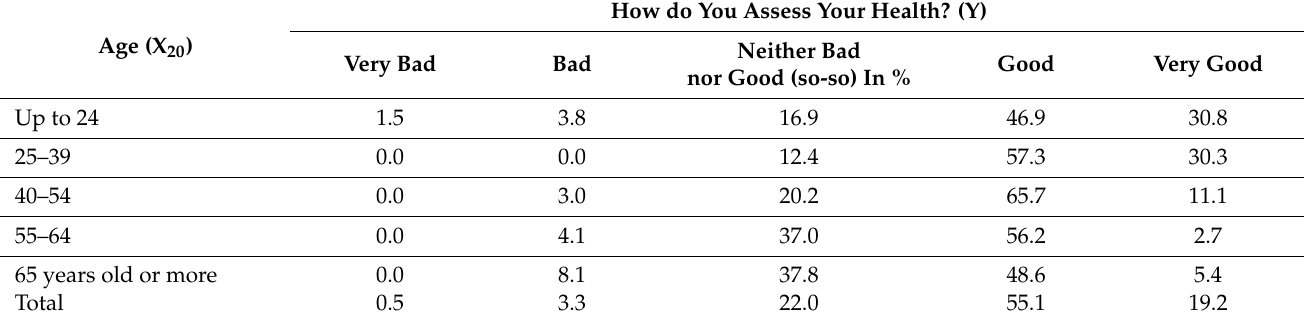
Table 2. Self-assessment of health status.